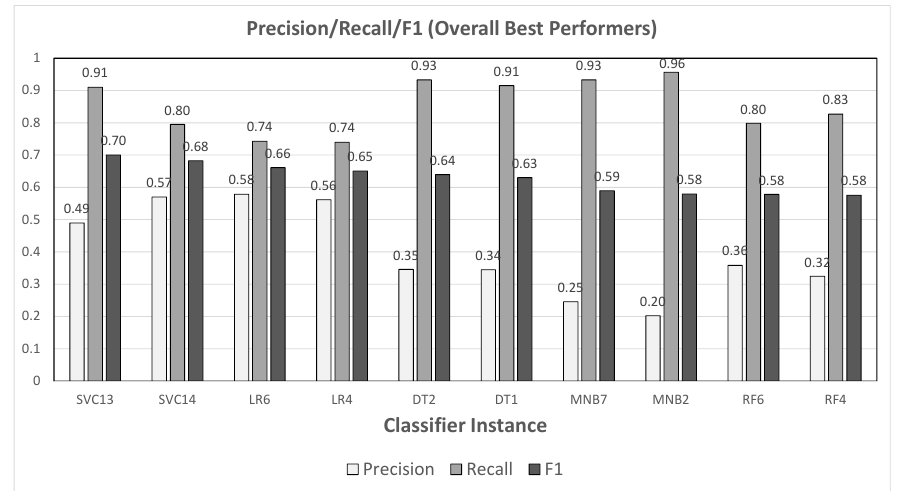
Figure 5. Best two performers from each chart in Figure 3, sorted by F1